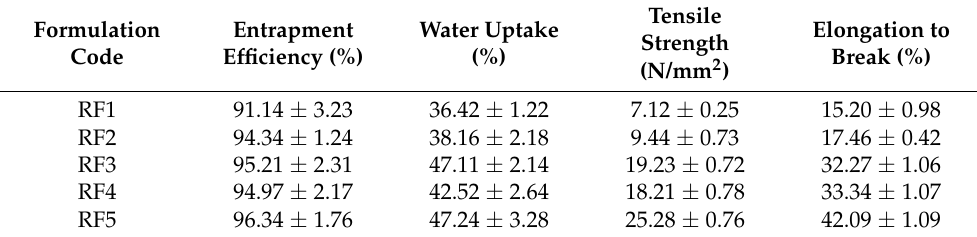
Table 2. Various parameters of formulation batches.